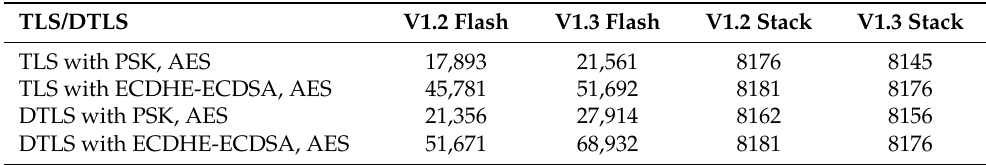
Table 6. Comparing TLS/DTLS configuration code